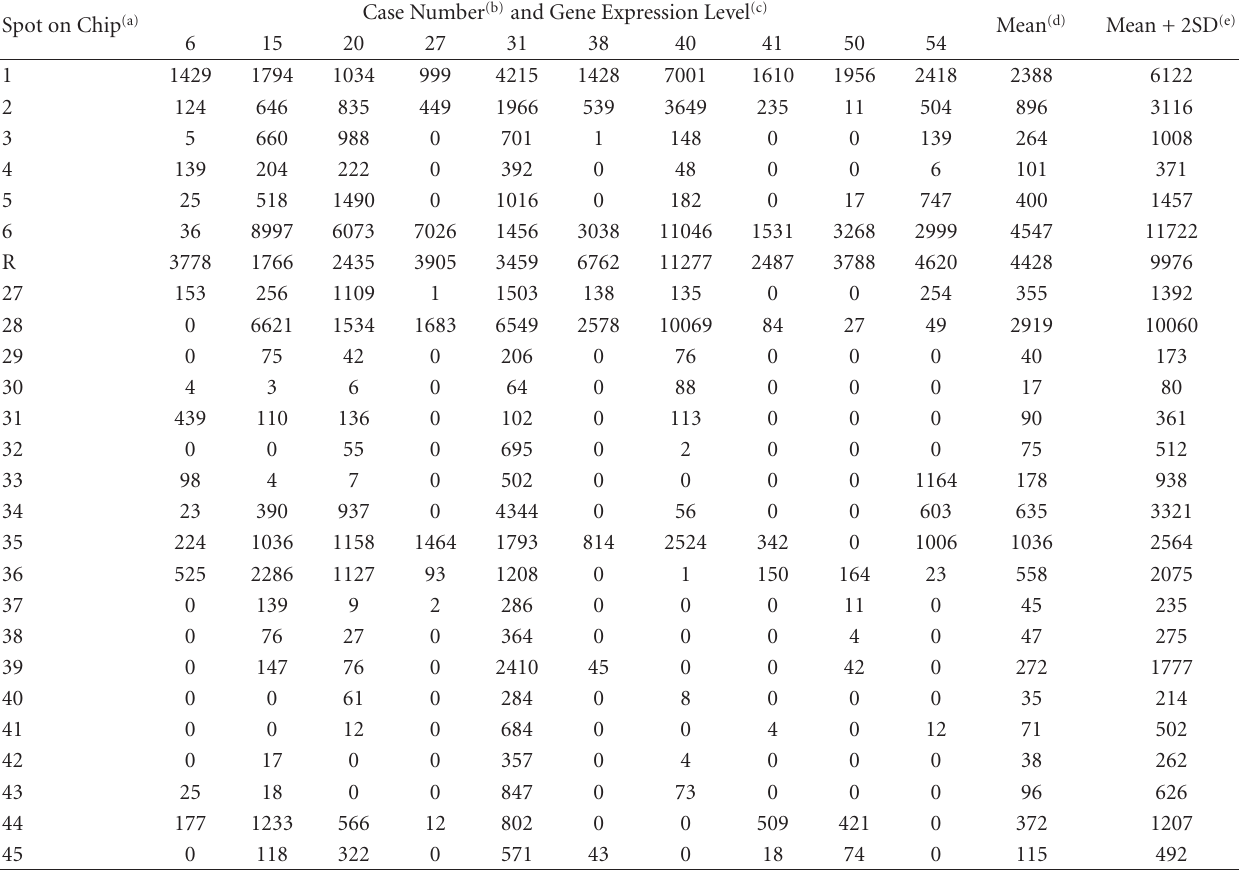
Table 3: Arbitrary viral gene expression levels in EBV-negative oral cancer